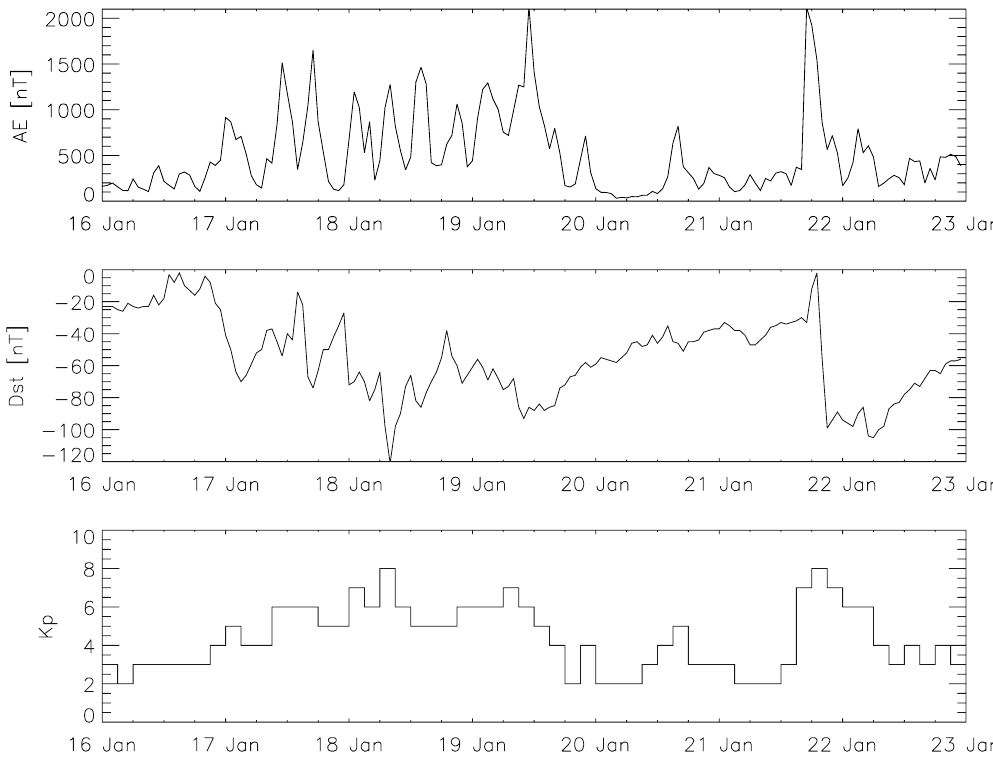
Fig. 1. Hourly AE and D st (upper and middle plot), and 3-hourly K p (bottom plot) for the period from 16–22 January